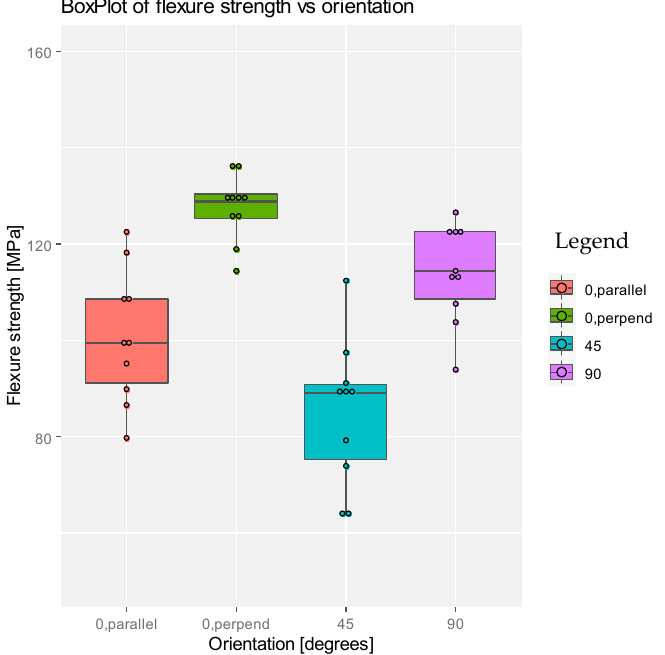
Figure 6. Boxplot representation for the flexure strength with respect to degrees of printing angle for the product DETAX.